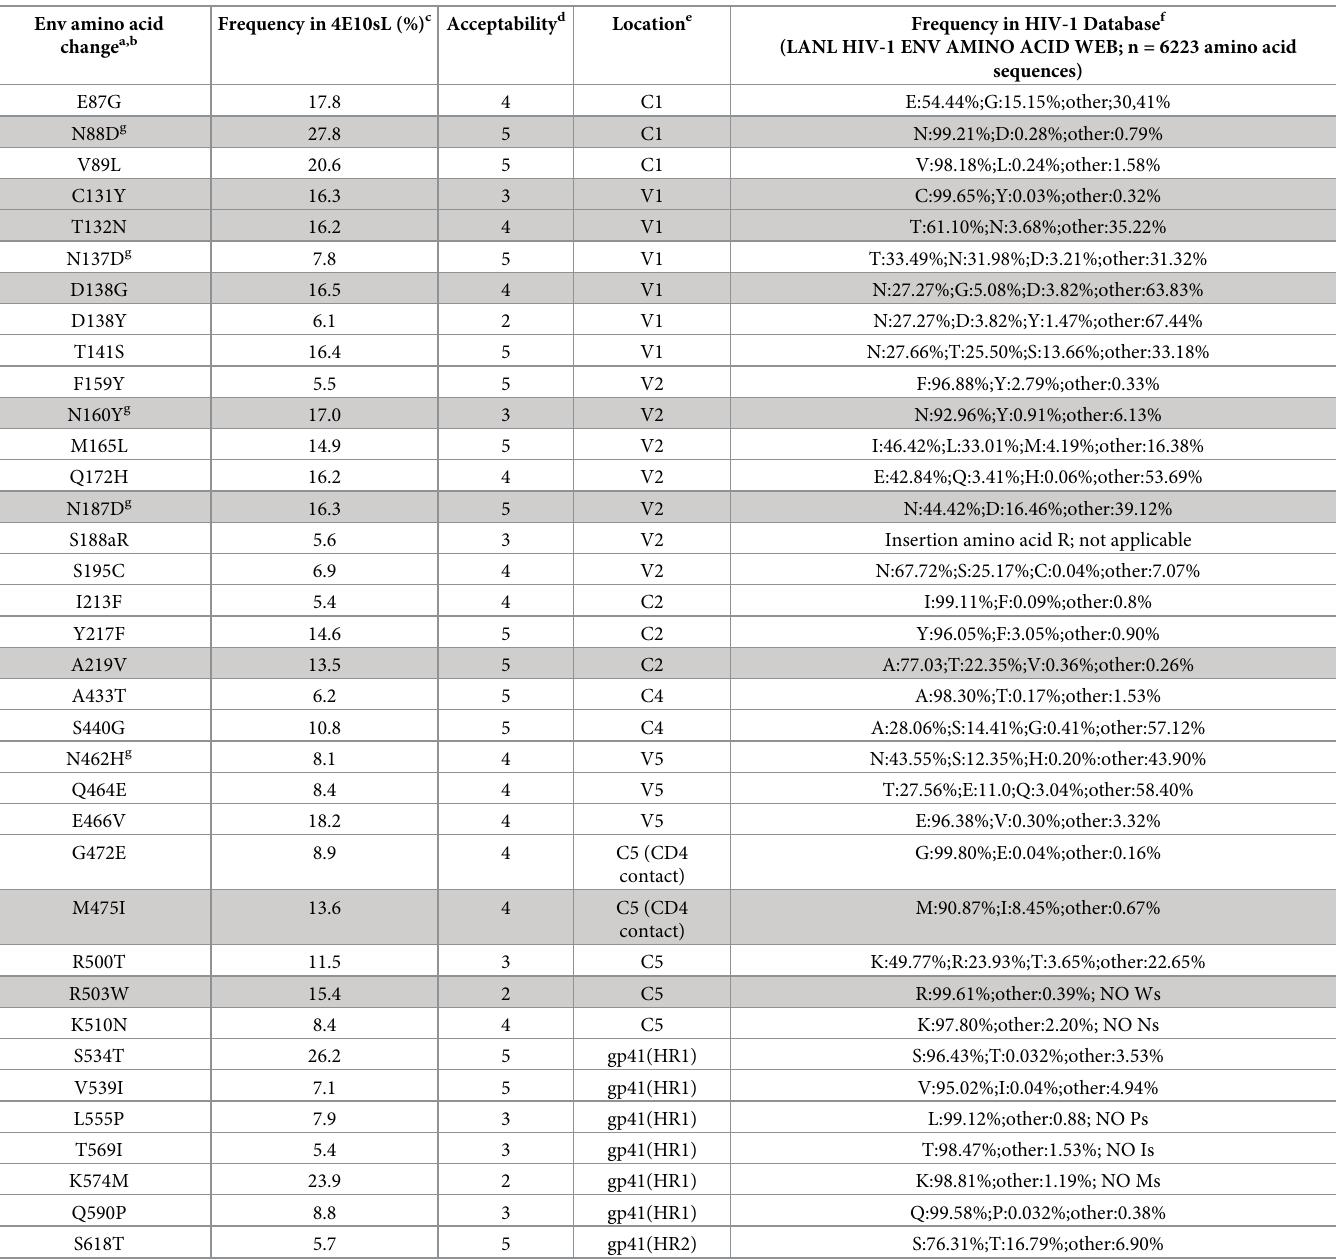
Table 2. Amino acid replacements in AC10_29 parental sequence with frequencies above 5% observed in the envelope library after 4E10 R.I.S. selection